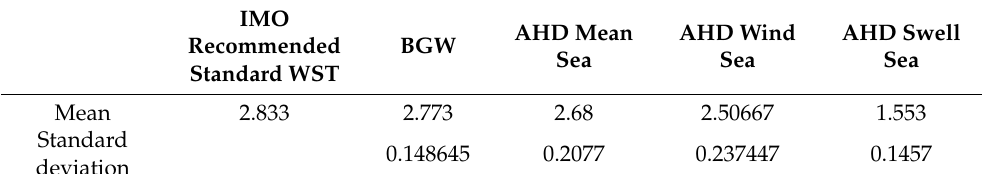
Figure 8. Plots of WST mean sea pdf (sea area S—full year).